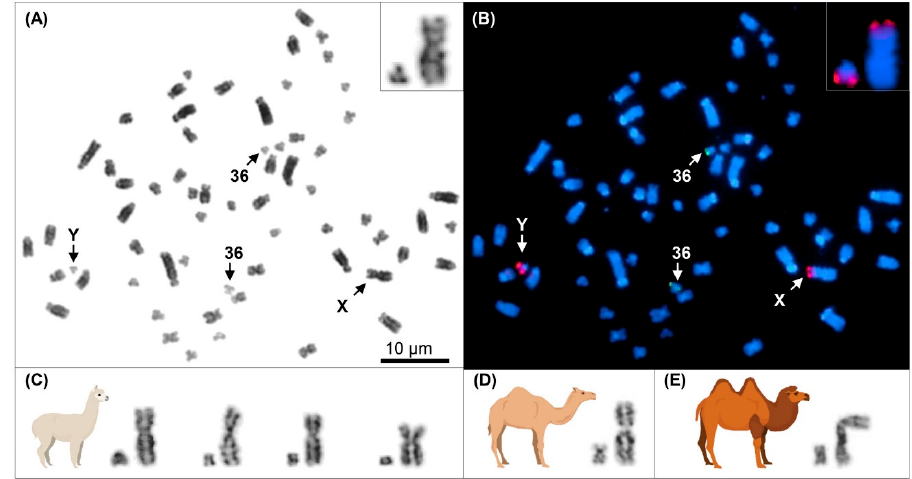
Figure 1. Cytogenetics of camelid sex chromosomes. ( A ) Giemsa stained alpaca metaphase spread showing (arrows) table 36. ( B ) The same metaphase after FISH with PAR BAC 21N1 (red) and chr36 BAC 3N14 (green) (Avila et al. 2014); Y and X with PAR signals are enlarged at upper right; ( C ) Alpaca Y and X chromosomes from 4 different cells; ( D ) Dromedary Y and X chromosomes, and ( E ) Bactrian camel Y and X chromosomes.